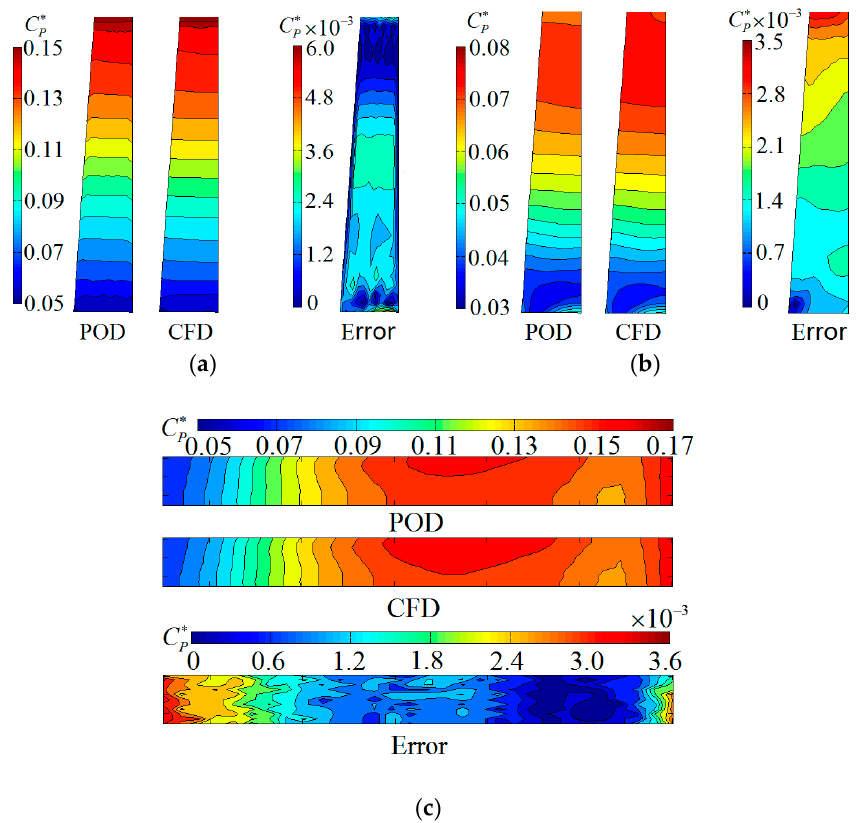
Figure 11. CFD calculation, POD reconstruction, and their error of pressure fluctuation intensity on the blade surface and circumferential surface of impeller outlet. ( a ) Pressure surface; ( b ) Suction surface; ( c ) Circumferential surface of impeller outlet.